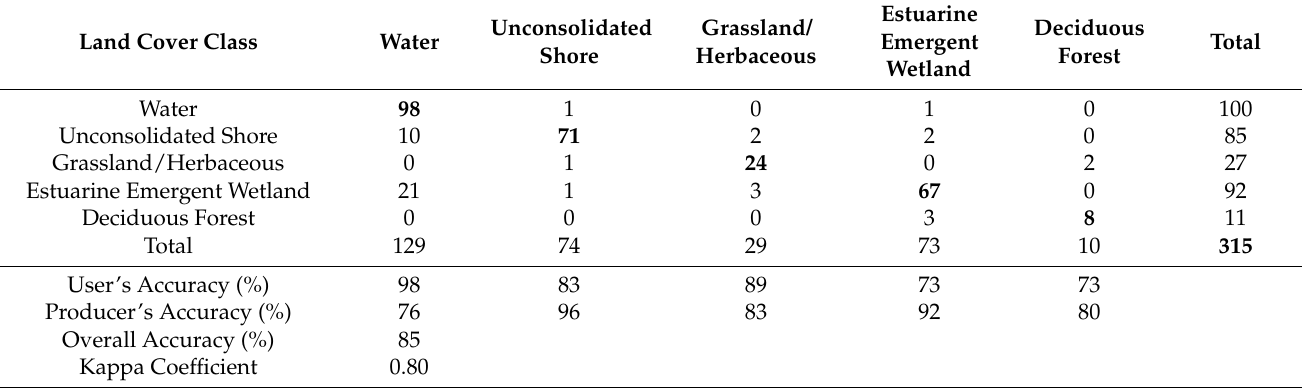
Table 3. Confusion matrix for the pre-Florence land cover classification and associated accuracy assessments. Bolded numbers indicate the correct number of pixels identified in each